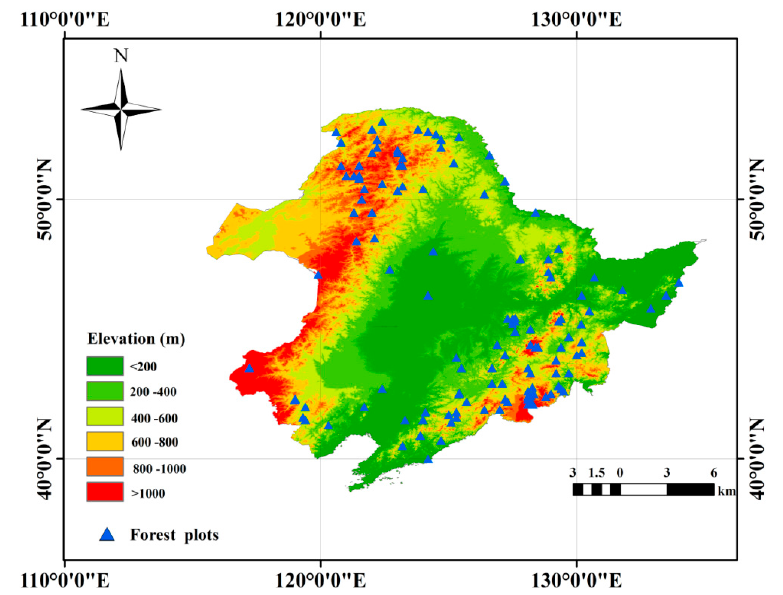
Figure 1. The study area and the biomass data collected in this study. These data are distributed well across the forest regions of the study area.